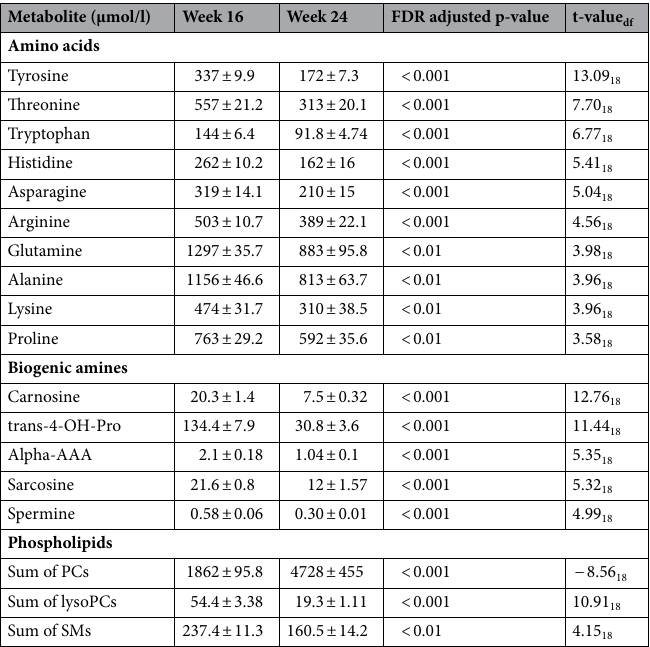
Table 2. LB hens—weeks 16 to 24: differential metabolite concentrations between weeks 16 and 24 in plasma according to FDR adjusted P-value from t-student’s test. Comparison between LB hens at 16 (n = 10) and 24 (n = 10) weeks of age. Values are showed as means ± SEM. ADMA asymmetric dimethylarginine, Alpha-AAA alpha-aminoadipic acid, Met-SO methionine sulfoxide, PC glycerophosphatidylcholines, SM sphingomyelins. FDR-adjusted p < 0.05 as significance level was used. t-value indicates the ratio between the difference between and within both groups. Degrees of freedom (df) are shown in the figure as subscript of